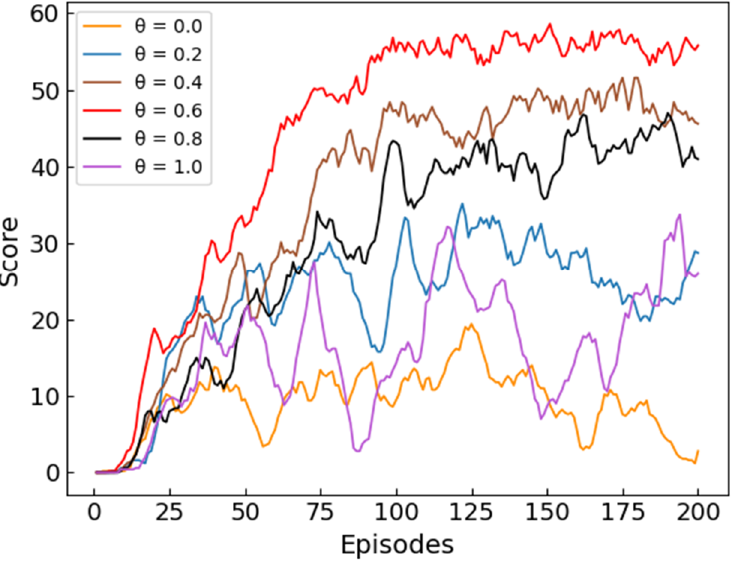
Figure 8. The reward accumulation process of each set of parameters.